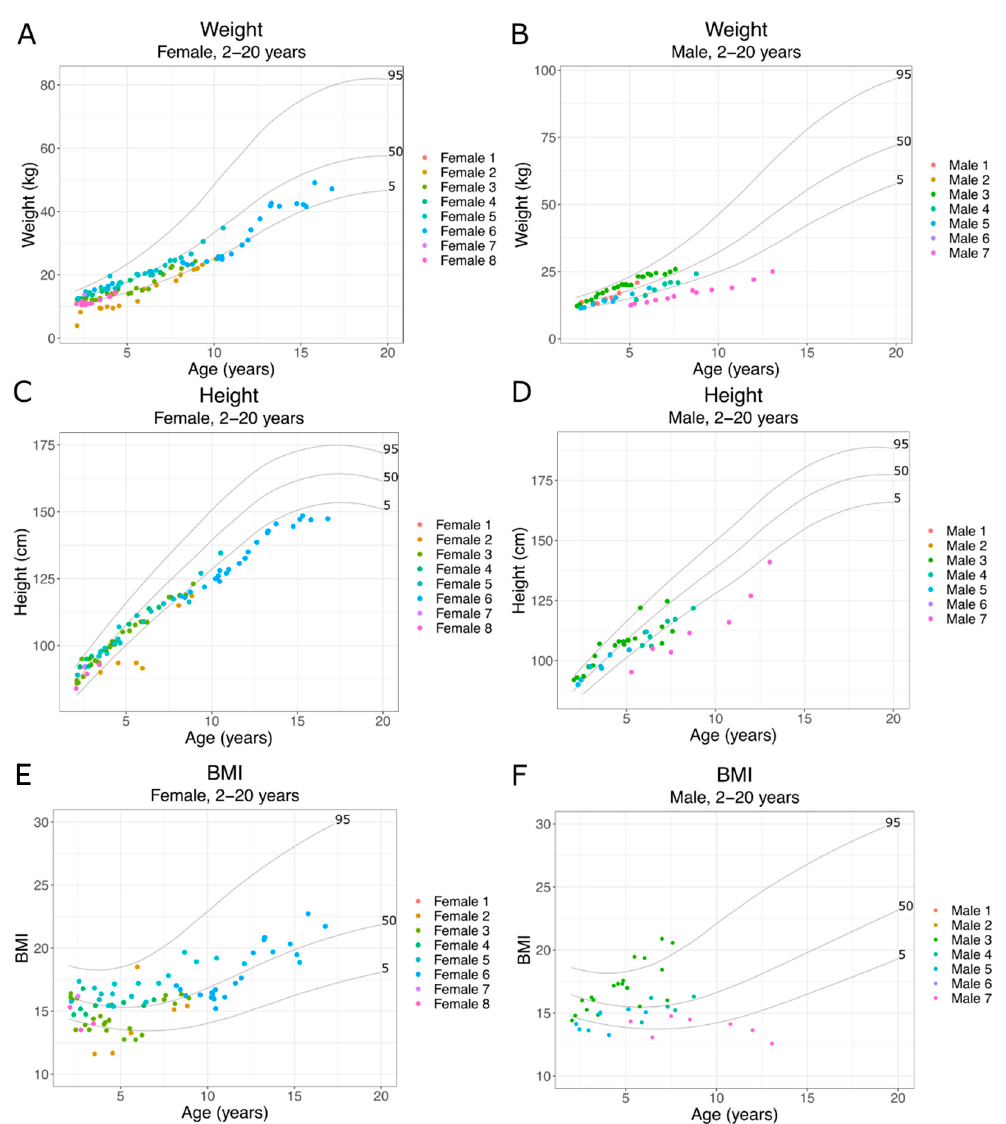
Figure 3. SLC13A5 Citrate Transporter Disorder patient growth 2–20 years : ( A ) weight of female patients 2–20 years; ( B ) weight of male patients 2–20 years; ( C ) height of female patients 2–20 years old; ( D ) height of male patients from 2–20 years old; ( E ) BMI of female patients 2–20 years; ( F ) BMI of male patients 2–20 years. Each panel includes the 95th, 50th and 5th percentiles from the CDC growth charts.